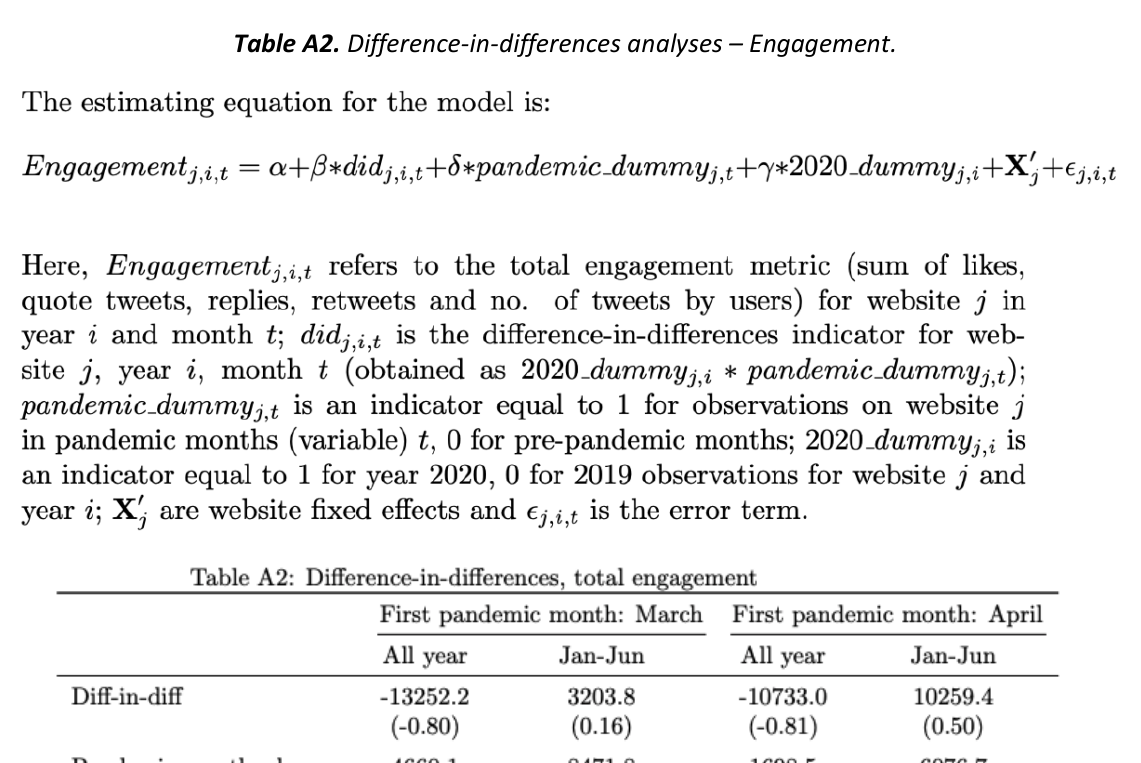
Table A1. List of coronavirus-related terms used in analysis.